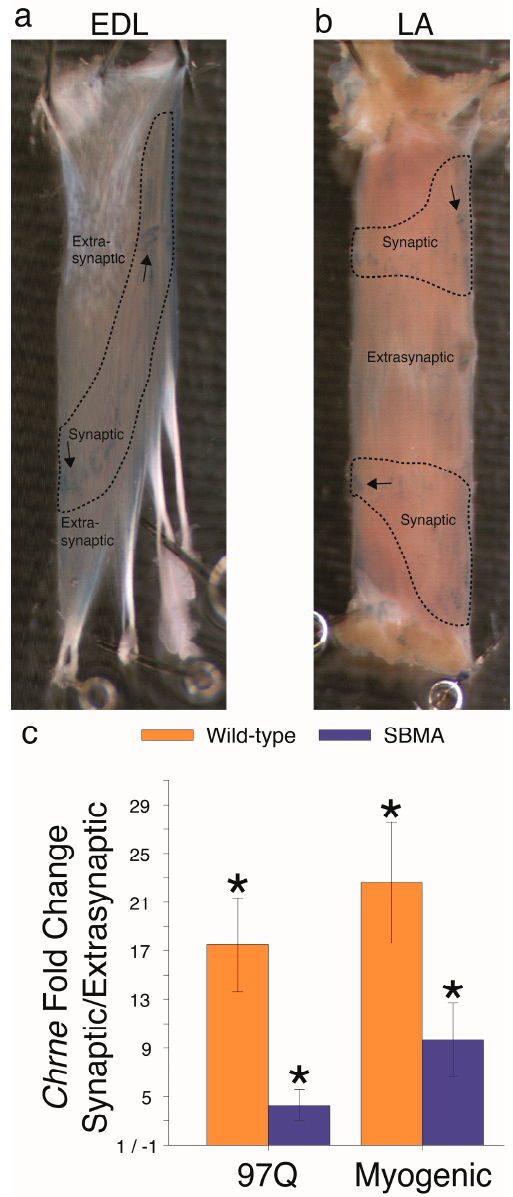
Figure 1. Levels of acetylcholine receptor epsilon subunit mRNA are significantly enriched in the synaptic region of WT and diseased muscle from two different SBMA mouse models. ( a , b ) The endplate, or synaptic region, of the muscle was localized by staining endplates (shown in blue, arrows) for